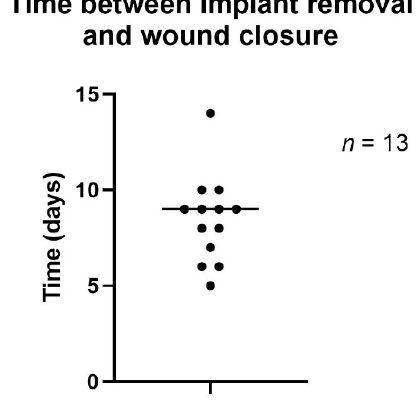
Figure 6. Time to wound closure after NPWTi-d.